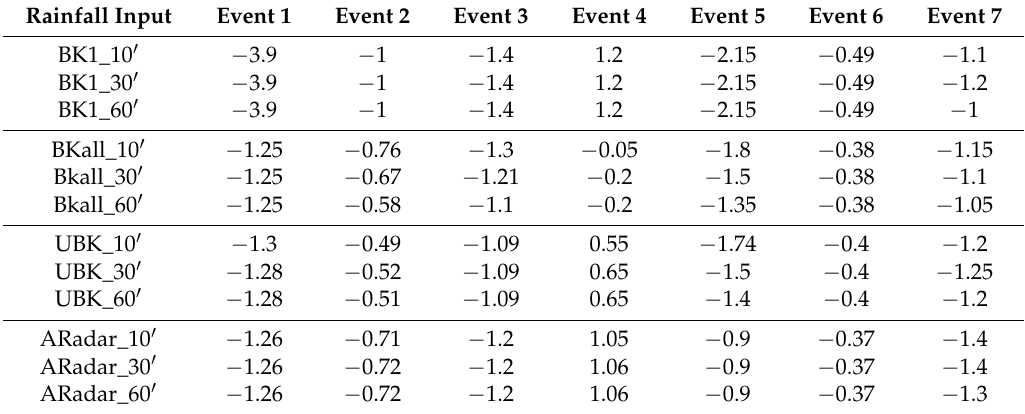
Table 4. Observed–modelled residual for the minimum dissolved oxygen concentration (g/m 3 ).